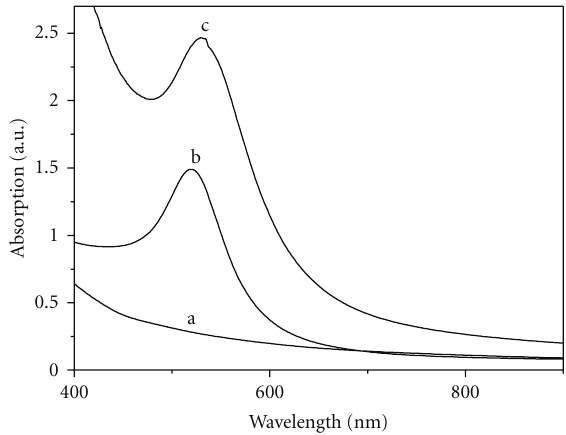
Figure 4: Absorption spectra of (a) Fe 3 O 4 and (b) Fe 3 O 4 @Au and (c)